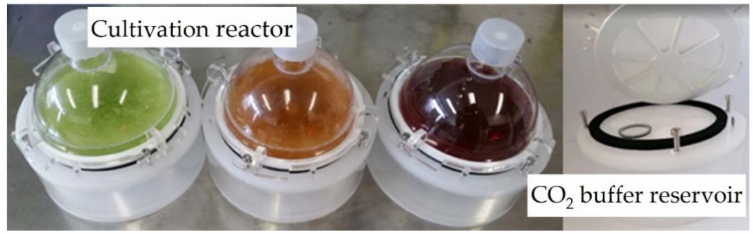
Figure 2. Photobioreactor HDC 1.100B filled with H. pluvialis cells at different cell